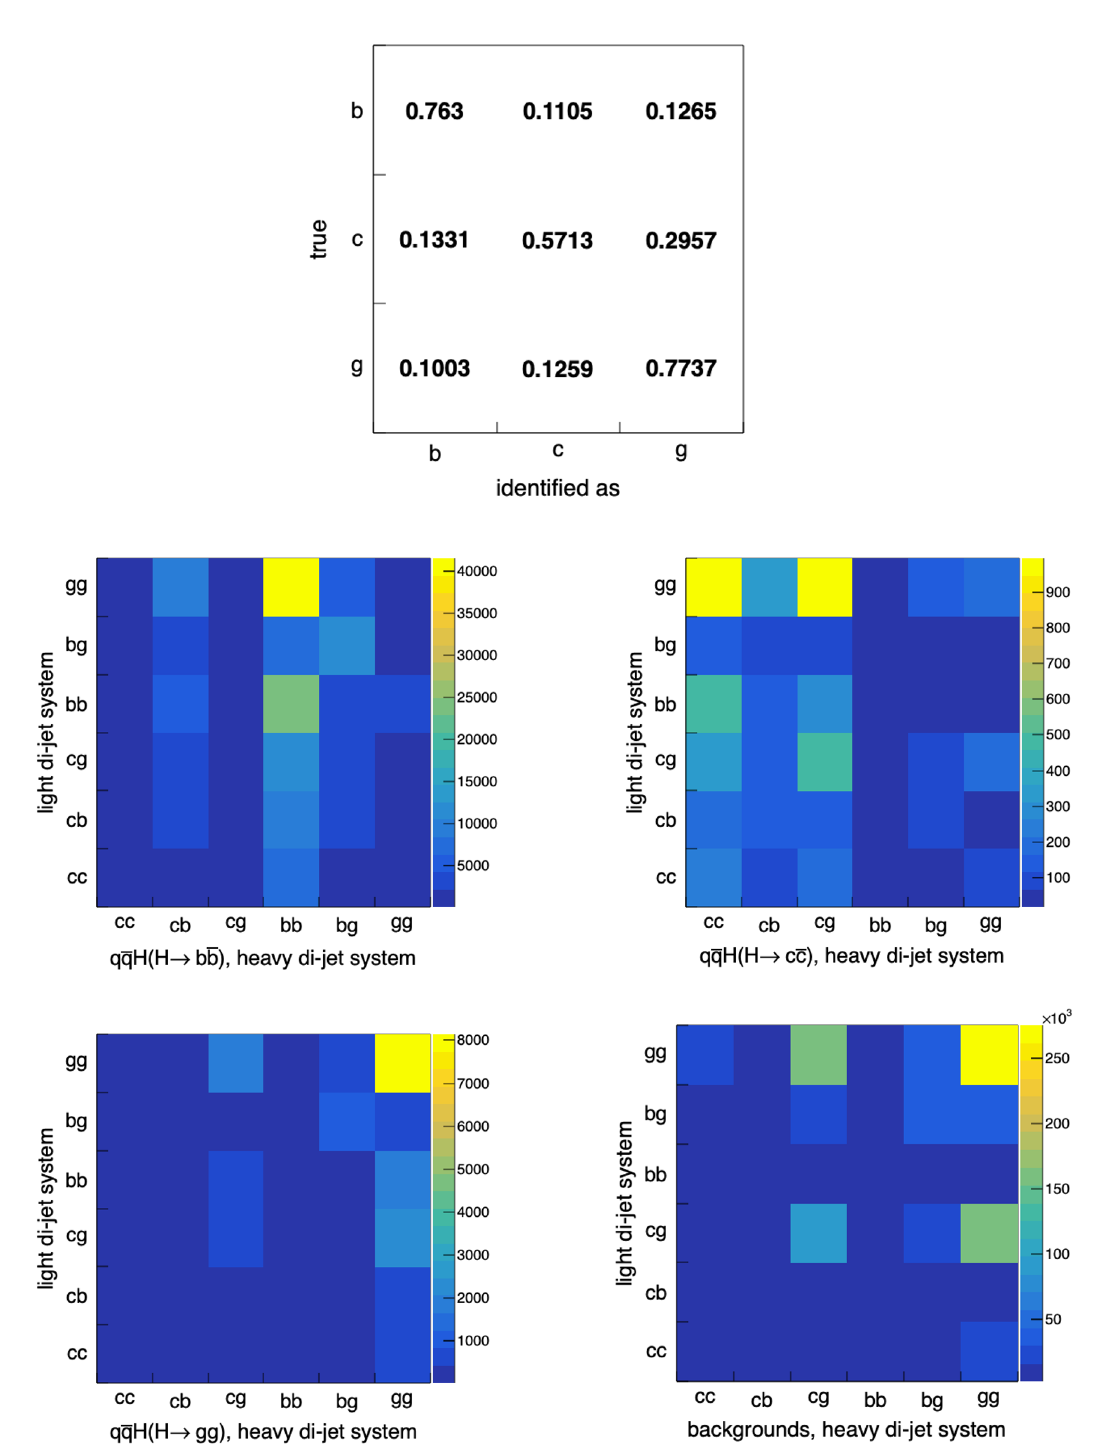
Figure 10 . The optimized flavor tagging performance matrix for heavy di-jet system (upper-left) and light di-jet system (upper-right). The distributions of q ¯ qH ( H → b ¯ b ) (middle left), q ¯ qH ( H → c ¯ c ) (middle right), q ¯ qH ( H → gg ) (bottom left), and backgrounds (bottom